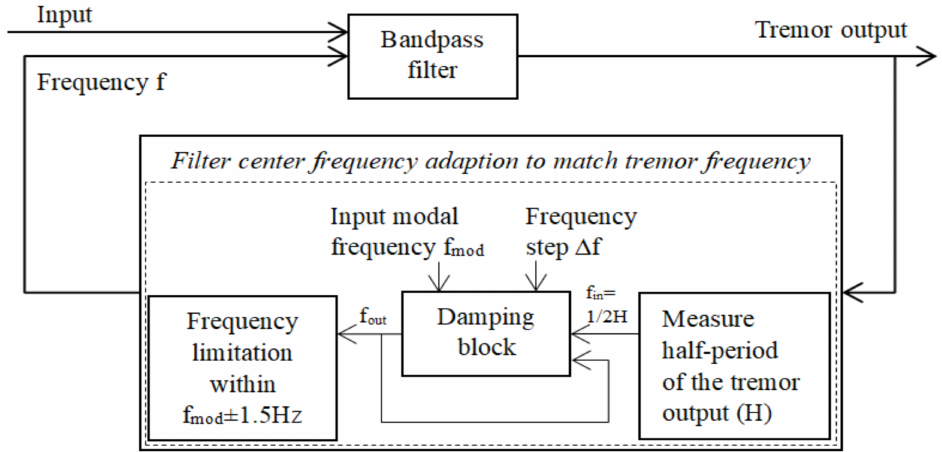
Figure 8. Main structure of the adaptive bandpass